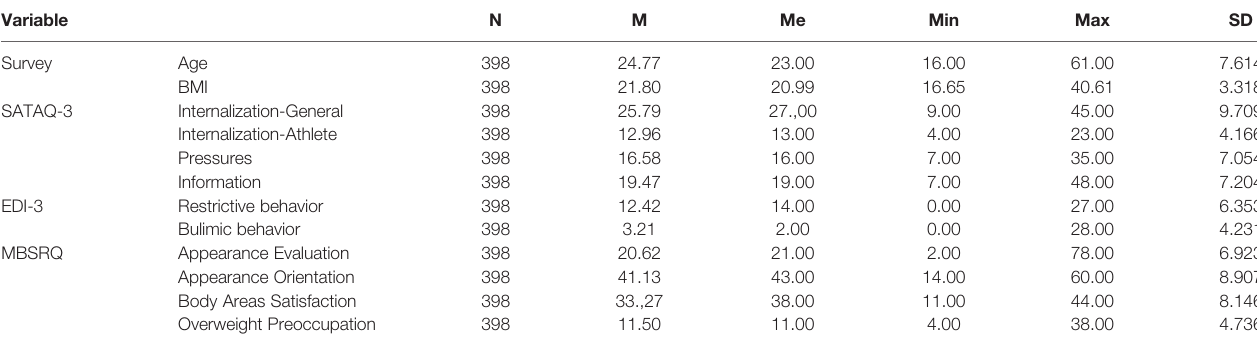
TABLE 2 | Descriptive statistics regarding variable values in the women group